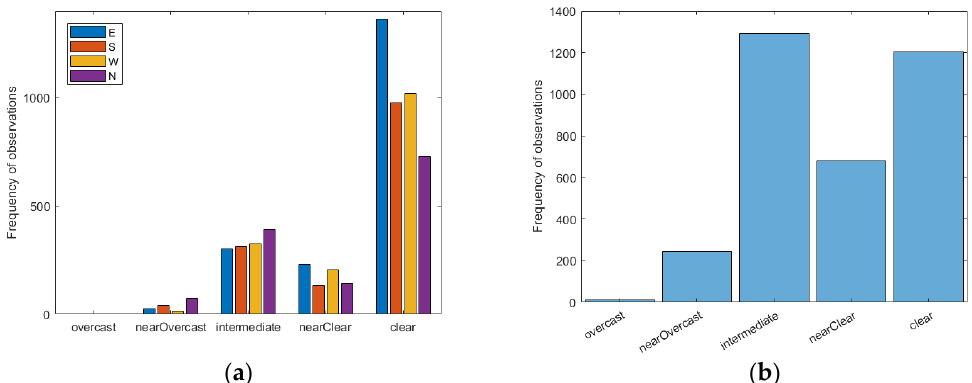
Figure 6. Histogram of the sky type according to Igawa et al. classification for ( a ) period under analysis in Spain and ( b ) full-year data, 2018 for NREL data.